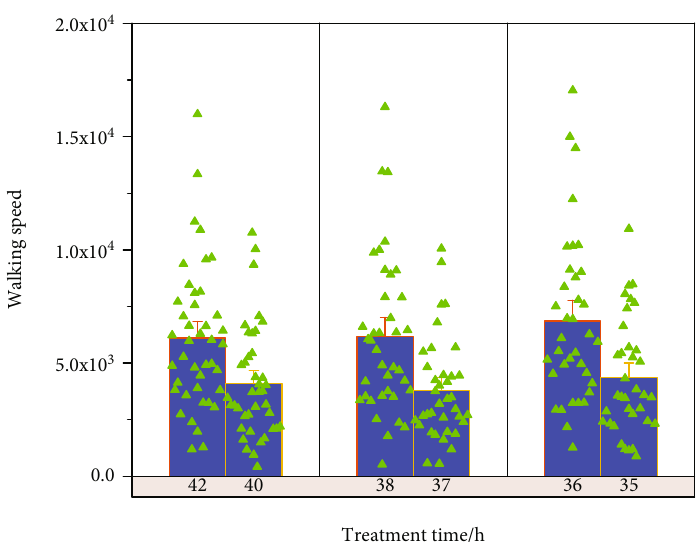
Figure 8: Comparison of two groups of